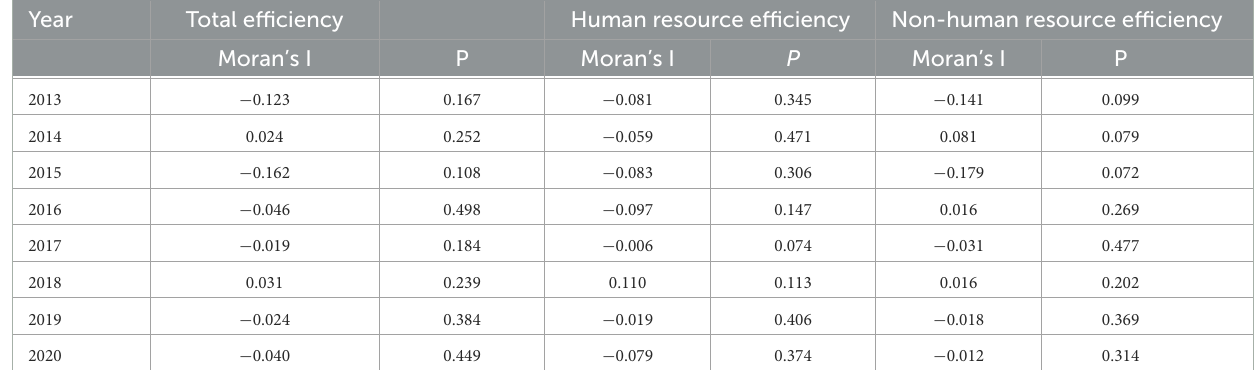
TABLE 5 The Moran’s I of human resources and non-human resources in